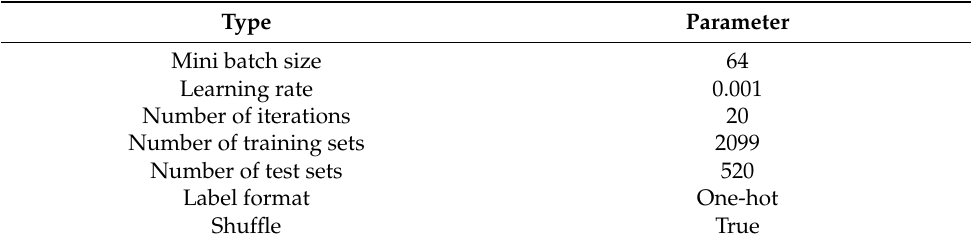
Table 5. Hyperparameters.